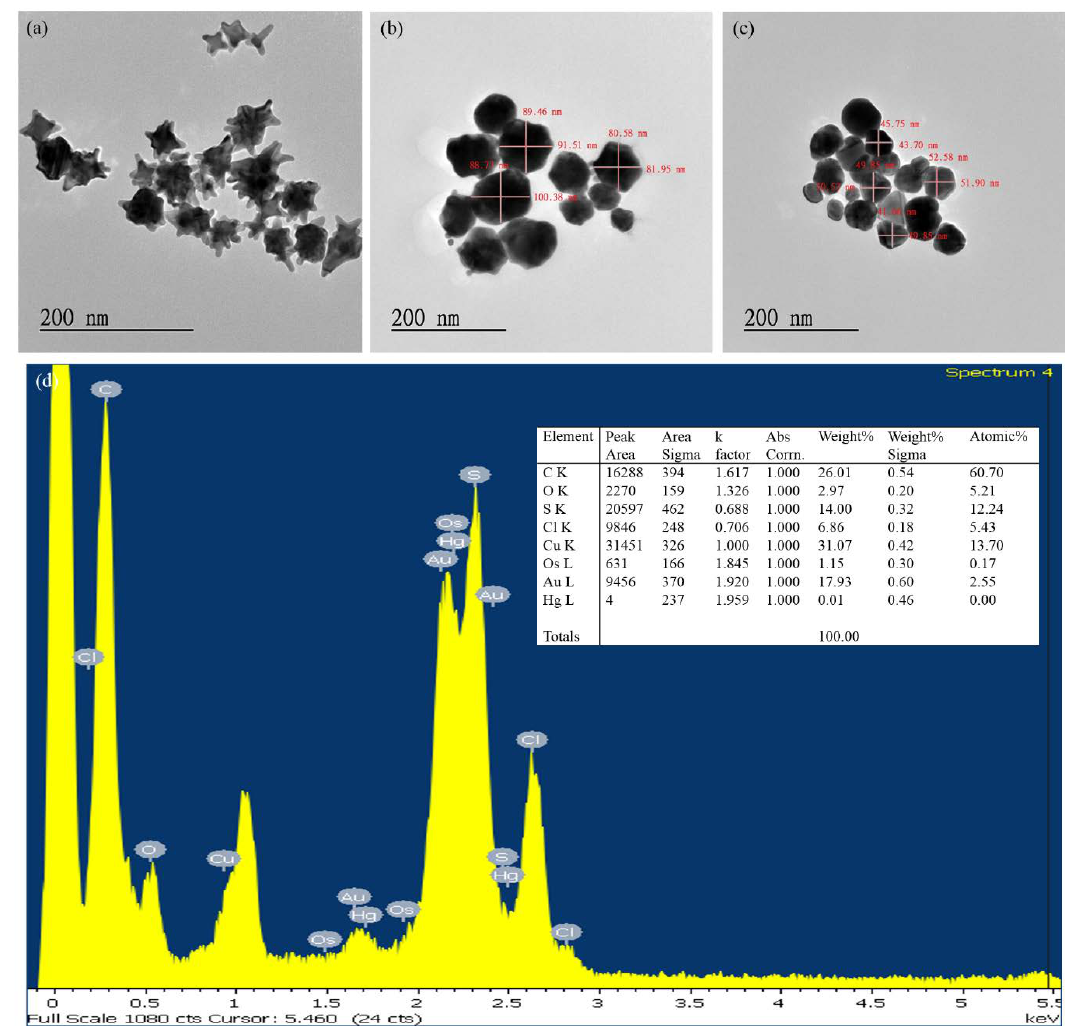
Figure 2. TEM images of ( a ) the H-AuNS probe prior to the reaction; and the H-AuNS probe ( b ) without and ( c ) with Hg(II) (1.0 µM) in the presence of HCl/Au(III)/H 2 O 2 solution. ( d ) EDX spectrum of the H-AuNS probe with Hg(II) in the presence of HCl/Au(III)/H 2 O 2 solution.